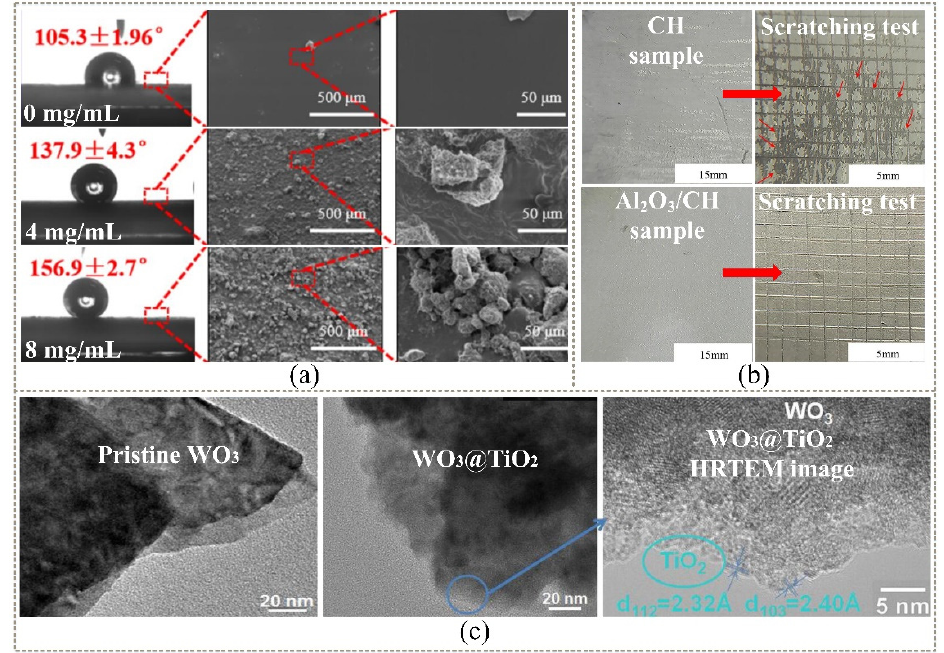
Figure 4. Preparation effects of the spraying methods: ( a ) effects of the content of carbon nanotube materials on coatings, non-wettability, and morphology [69]; ( b ) scratching methods to evaluate the adhesion strength of the layers [70]; ( c ) TEM images of pristine WO 3 and WO 3 @TiO 2 nanocomposite film [72].